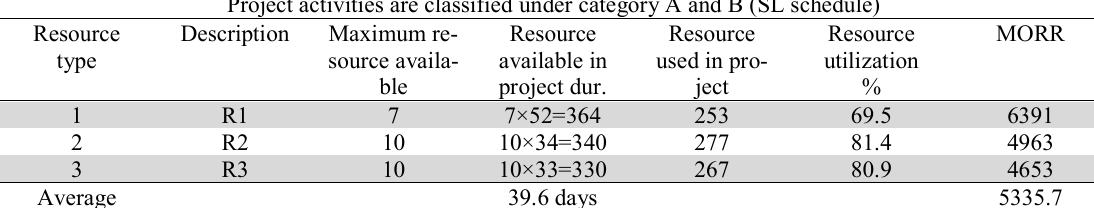
The value of the objective function obtained under SL priority rule for case 2 Project activities are classified under category A and B (SL schedule)